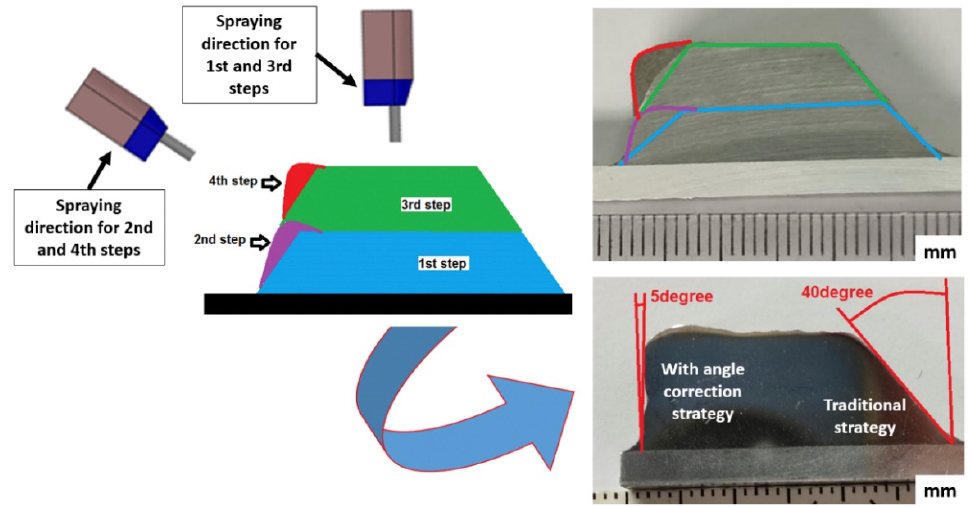
Figure 2. Scheme of strategy to compensate the sidewall inclination. The CSAM part cross-section is 316L on Al substrate.